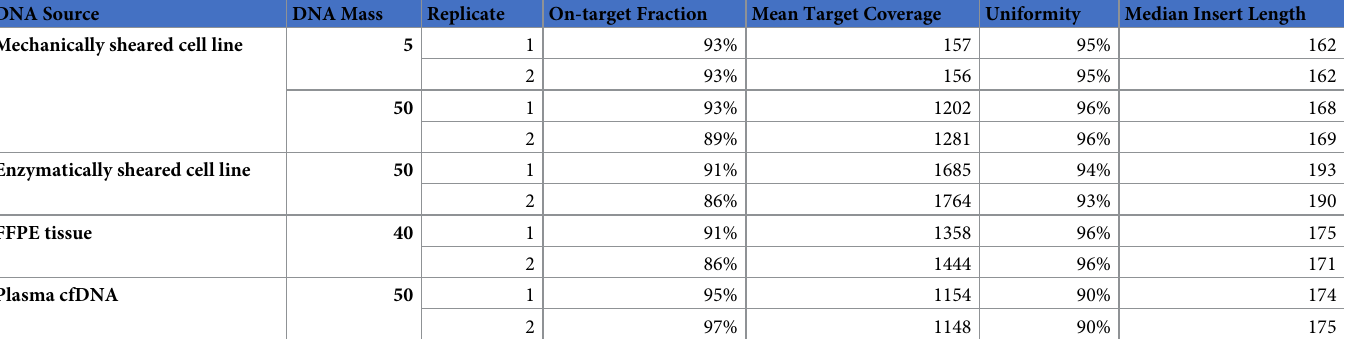
Table 1. LTC 35-gene sequencing performance data for two replicates of sample type and DNA mass. On-target fraction was defined as the fraction of total bases that aligned to the target regions. Mean target coverage was defined as the mean de-duplicated coverage over all target regions, and uniformity was defined as the fraction of on-target bases that were covered within two fold of the mean target coverage (i.e. between 0.5x and 2x of the mean). Median insert length was measured over all de-dupli- cated on-target